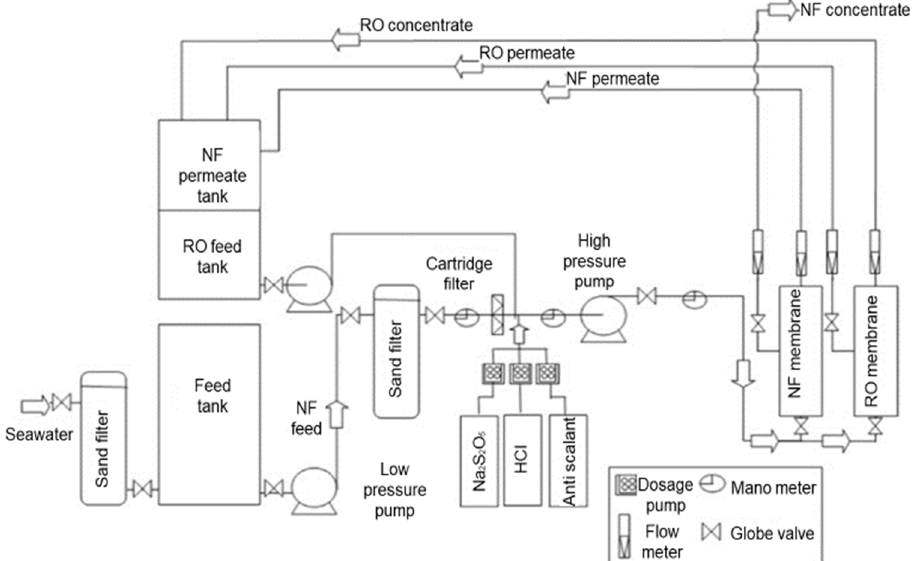
Figure 10. Flow diagram of the NF + SWRO integrated desalination process. Reprinted from [117] with permission from Elsevier, 2015.